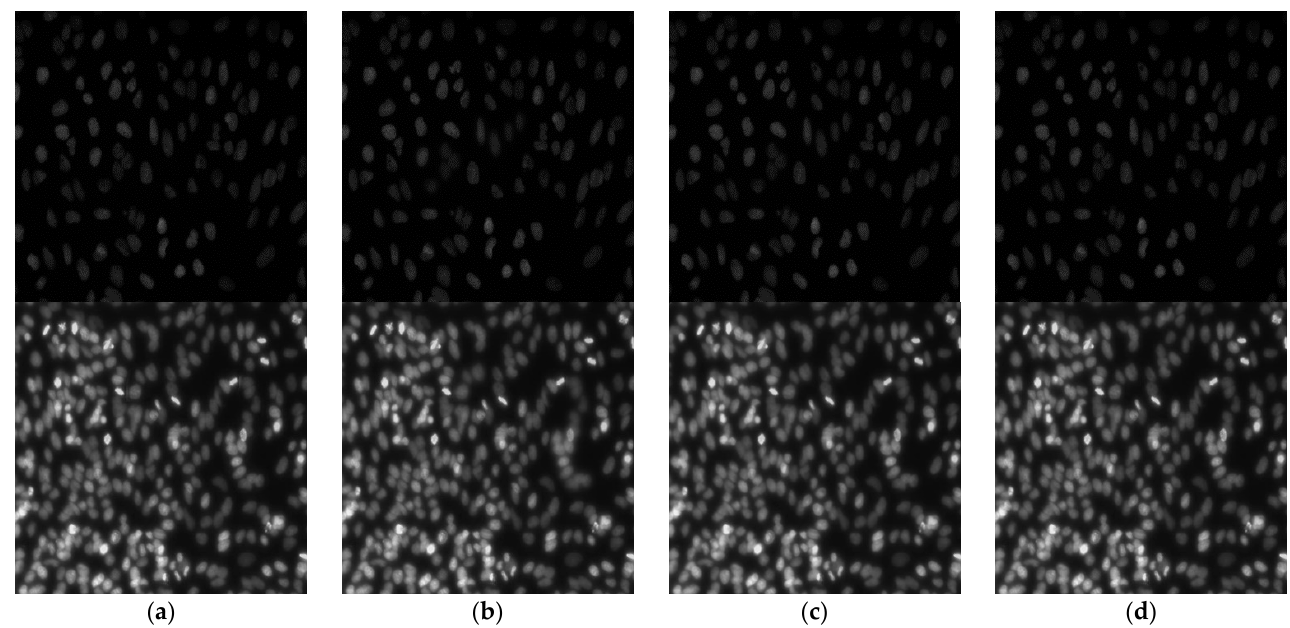
Sensors 2021 , 21 , x FOR PEER REVIEW